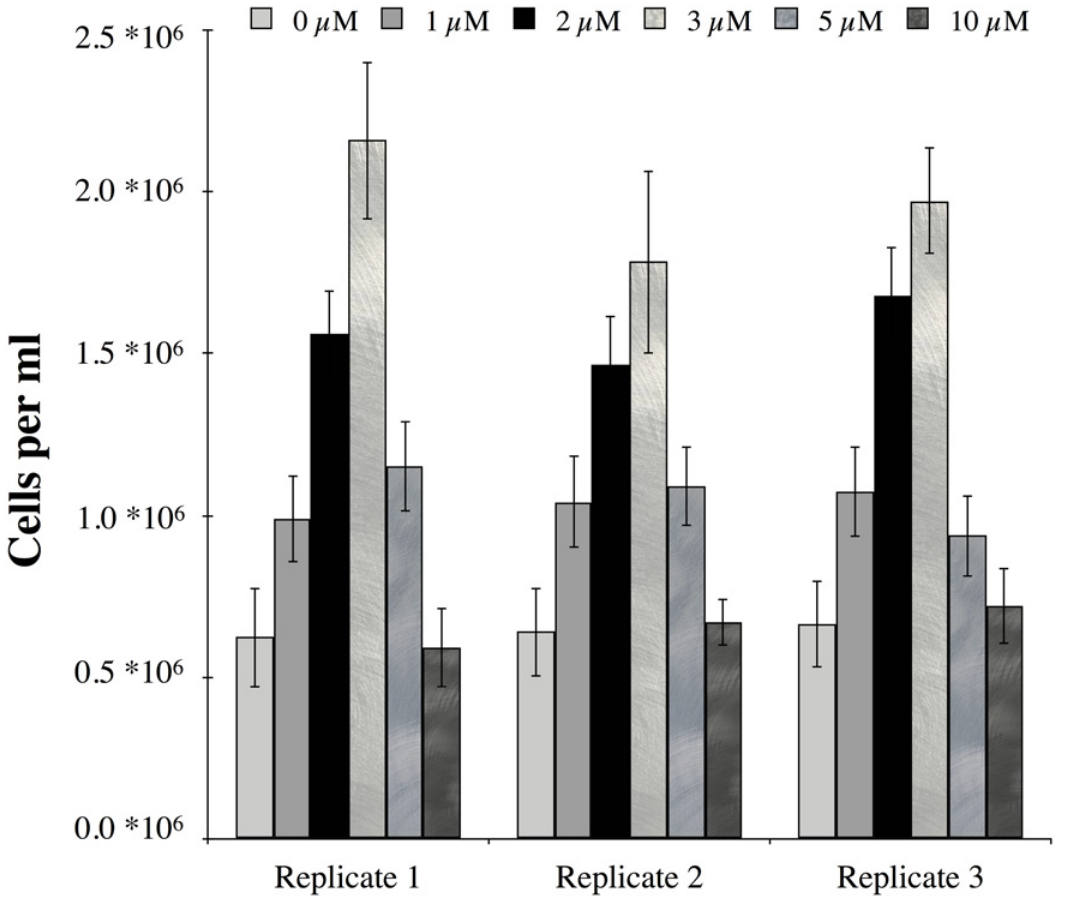
Fig 2. Changes in cell number in replicate microcosms with the various uranyl acetate additions (0 – 10 μ M) after a 24-day incubation. Error bars indicate the variability (SD) in the cell counts for each replicate. strain Rifle MnlI -peak (166 bp) represented the Burkholderia fungorum strain Rifle isolate was done by digesting a subset of the amplicons using the endonuclease Eag1 (6-bp cutter) that